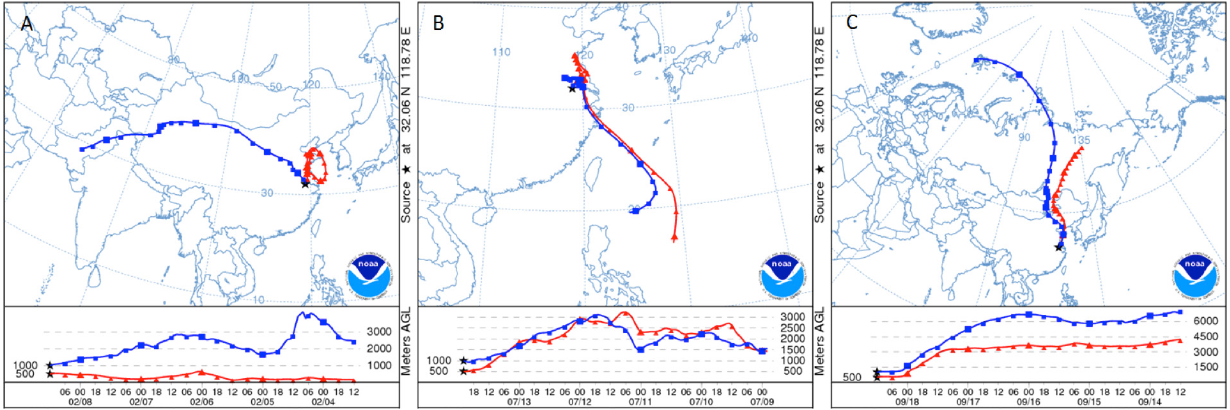
Figure 3. Five-day HYSPLIT backwards trajectories arriving in Nanjing, China, on ( A ) 8 February 2011, at 18:00 UT, ( B ) 13 July 2011, at 22:00 UT, and ( C ) 18 September 2011, at 12:00 UT.